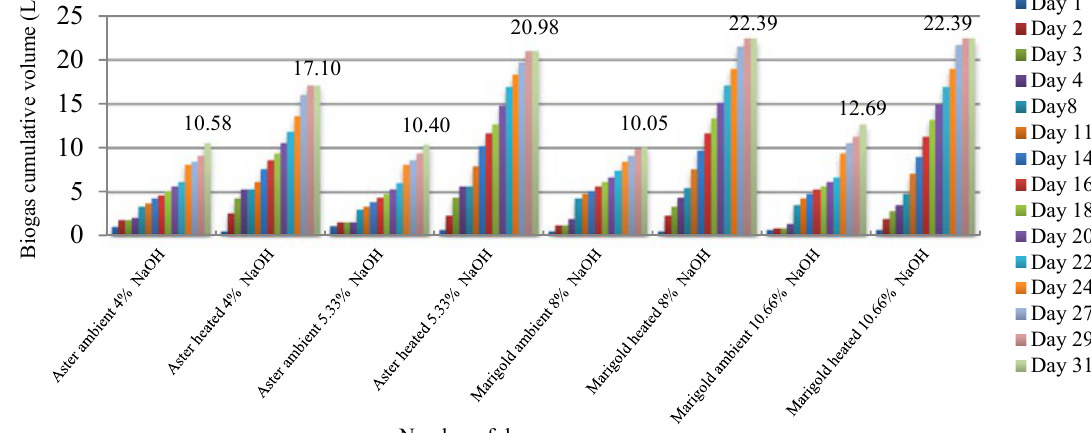
Fig. 3: Biogas generation from aster and marigold flowers (150 g) with and without solar heating of the digester